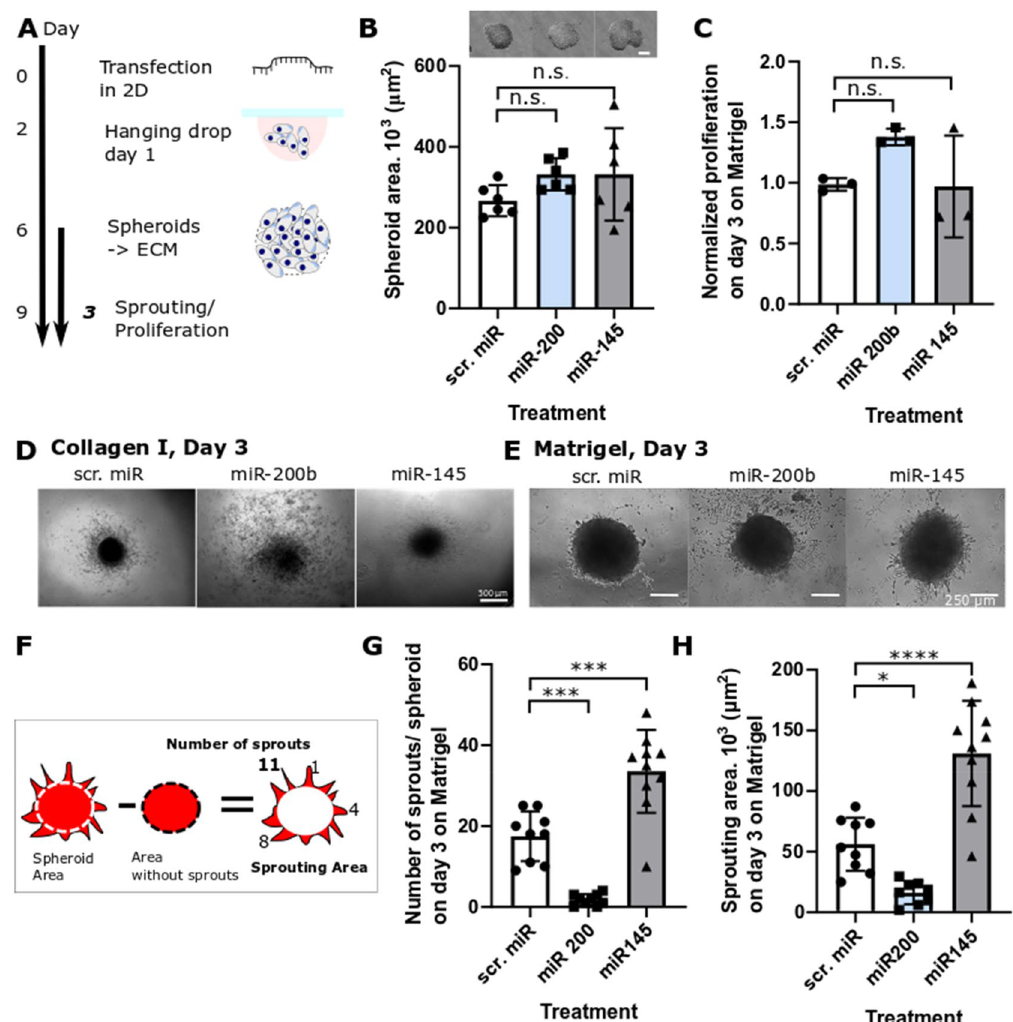
Figure 6. The effect of microRNA on 12Z sprouting on Matrigel. ( A ) Schematic of the workflow ( B ) none of the microRNAs affected the ability of 12Z cells to self-organize into spheroids and all groups resulted in spheroids with similar area (scale bar = 250 µm, n = 6 independent spheroids prepared across two preparations, ANOVA). ( C ) None of the microRNA affected overall metabolic activity measured as luminescence compared to scr.miR treated controls. Data are normalized to controls without any microRNA (n = 3 independent wells, ANOVA, one repeat). ( D ) Representative images of microRNA treated 12Z spheroids after 3 days on collagen I. Scale bar, 500 µm. ( E ) Representative images of microRNA treated 12Z spheroids after 3 days on Matrigel. Scale bar, 250 µm. ( F ) A diagram showing how the number of sprouts and the sprouting area parameters were calculated. ( G ) miR-200 significantly decreased while miR-145 significantly increased the number of sprouts per spheroid after 3 days on Matrigel. (n = 9–10 independent wells across two independent preparations, ANOVA, Tukey’s multiple comparisons). ( H ) The overall area occupied by sprouts was significantly larger and smaller when treated with miR-145 and miR-200b, respectively, compared to scr.miR after 3 days on Matrigel (n = 8–10 independent wells across two different preparations, ANOVA, Tukey’s multiple comparisons, two independent experiments), *p < 0.05; **p < 0.01; ***p < 0.001 and n.s. p > 0.05; data expressed as mean ±